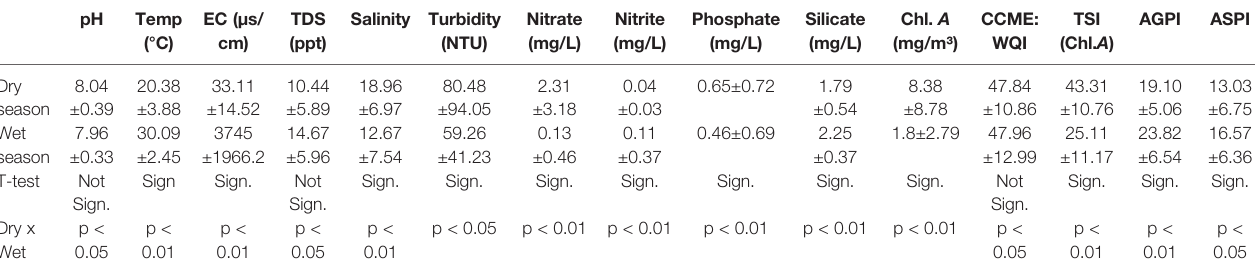
TABLE 2 | The temporal and spatial variation of environmental parameters and pollution indices during study